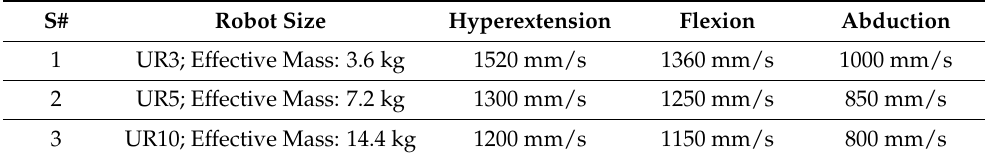
Table 3. Summary of Robot Speed